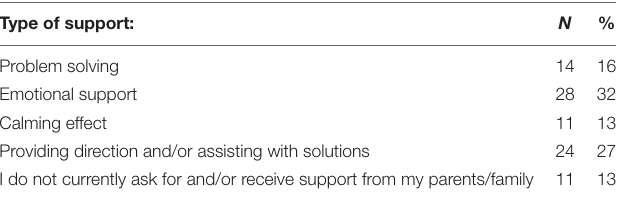
TABLE 4 | Type of support offered by parents to undergraduate college